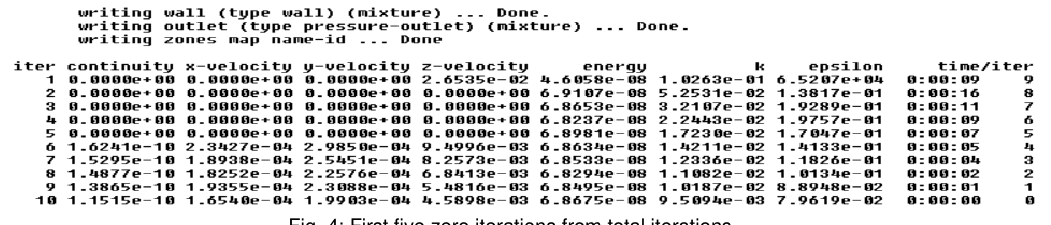
Fig. 3: Control of Pressure for 300nm radius and 3.1mm length straight circular channel